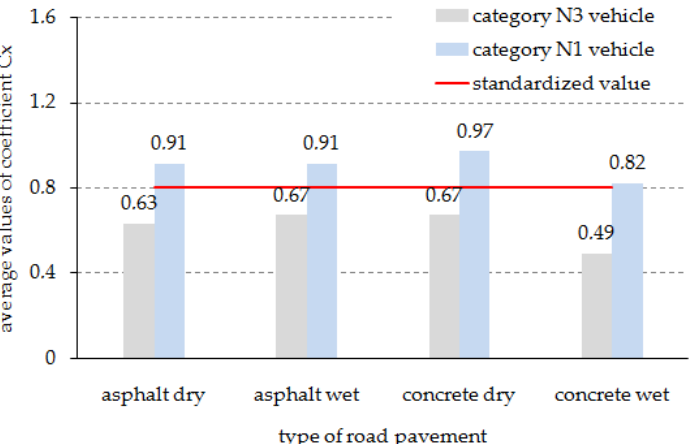
Figure 8. Average values of coefficient C x established for fully developed deceleration values during braking tests performed with an initial speed of 30 km/h.